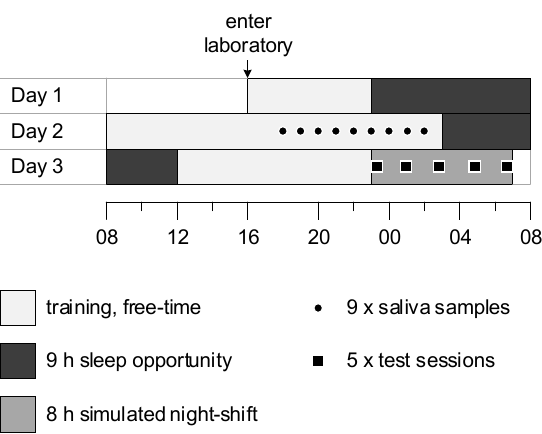
Figure 3. Protocol diagram. Y-axis represents days in the protocol; x-axis represents time of day.